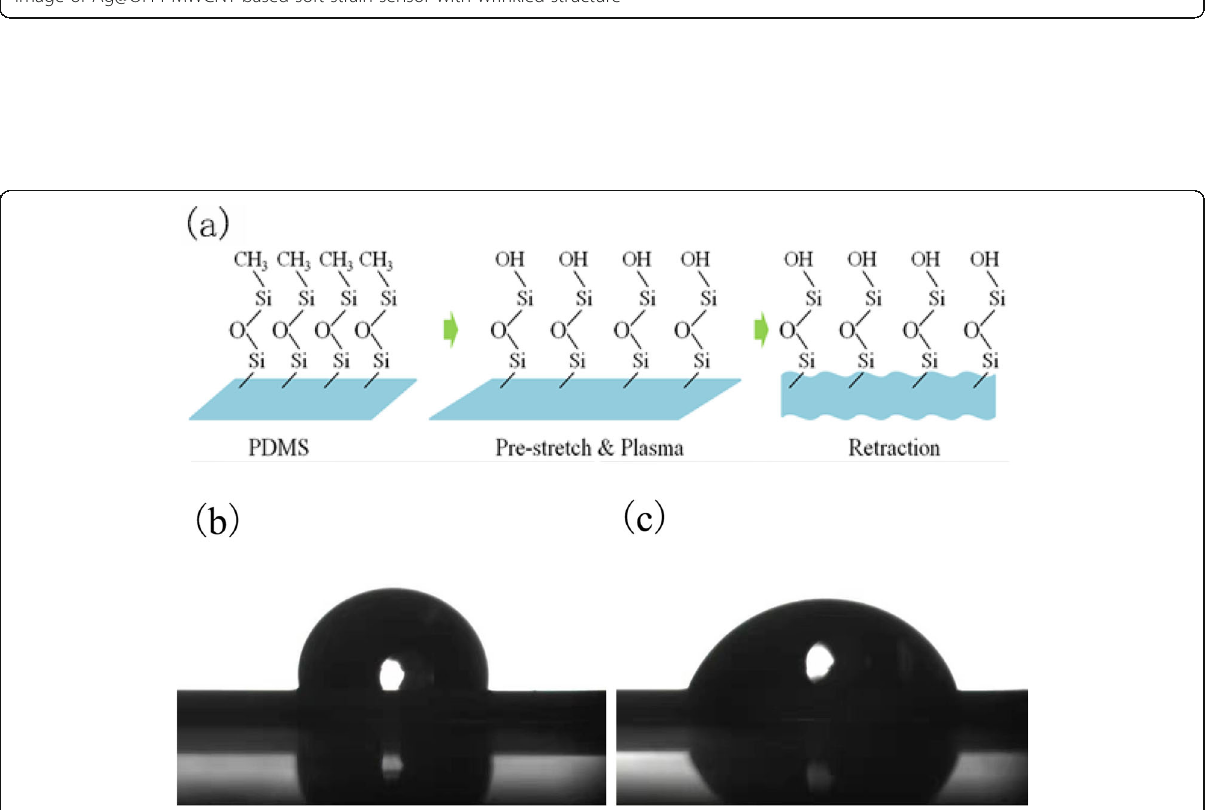
Fig. 3 Water contact angle of PDMS ( a ) before and ( b ) after oxygen plasma surface treatment. c Schematic model of PDMS pre-stretching and oxygen plasma surface